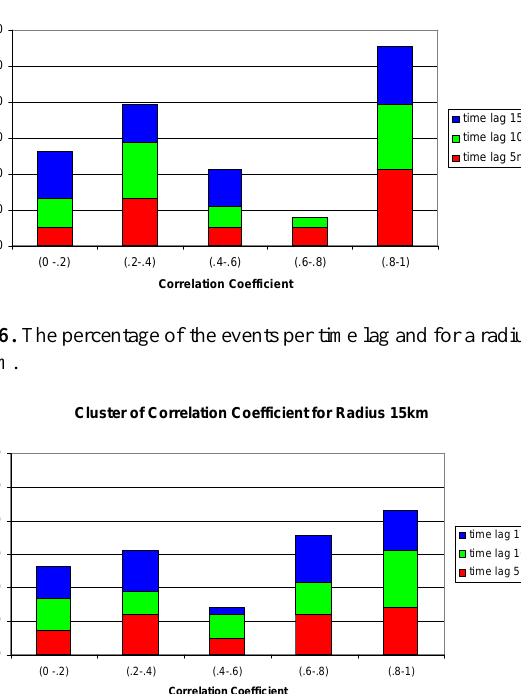
Fig. 7. The percentage of the events per time lag and for a radius of 15km.